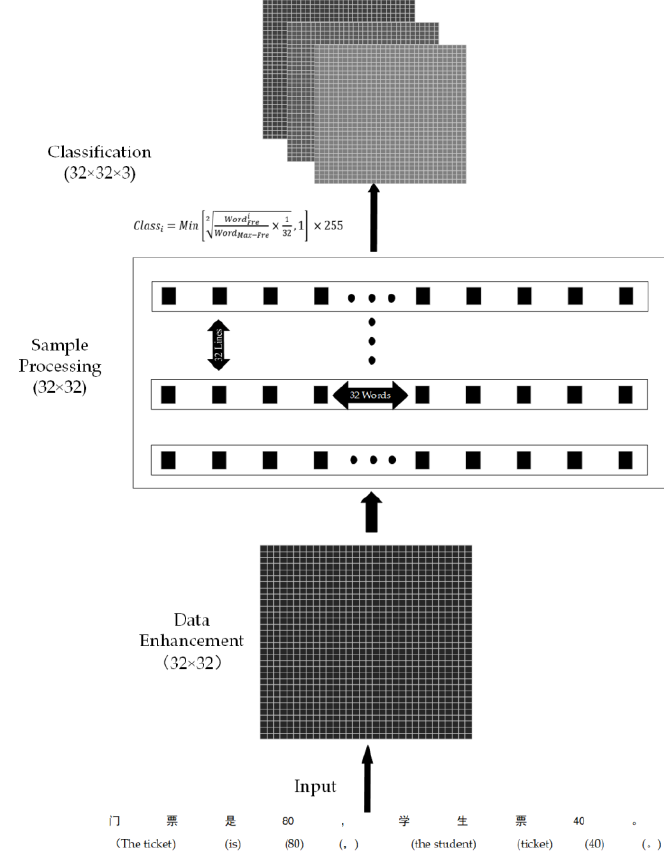
Figure 1. TTP flow diagram.